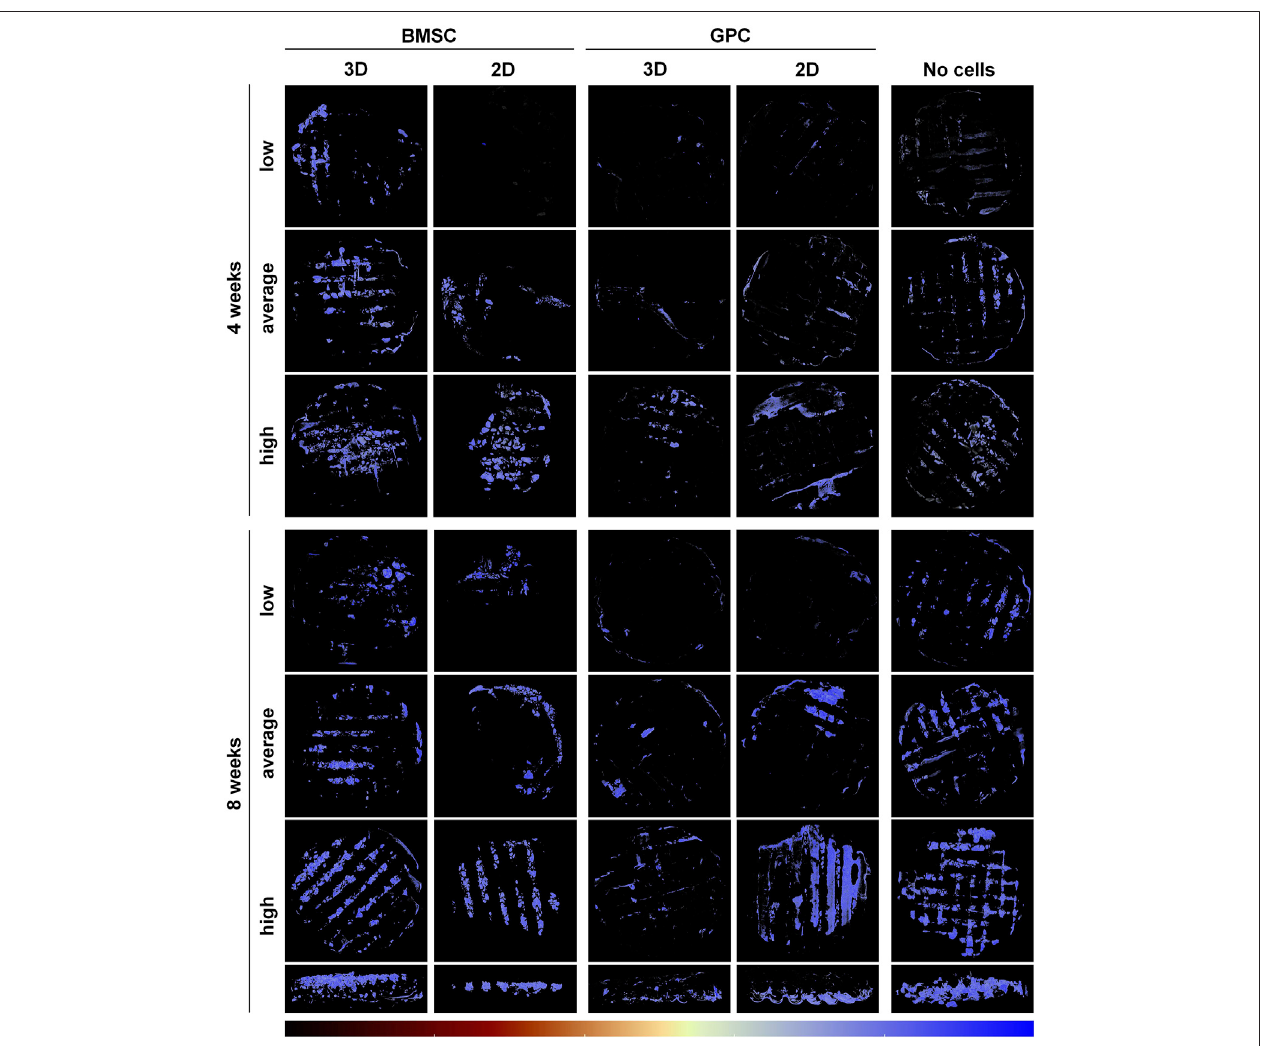
FIGURE2| μ CTanalysisofectopicmineralization.Representativereconstructedimagesshowing “ low,averageandhigh ” degreesofmineralizationinBMSC,GPC and control constructs (no cells) after 4 and 8 weeks; the bottom row shows cross-sectional views of the corresponding “ high ” constructs at 8 weeks. The color bar indicates relative mineral density from minimum (black) to maximum (blue).